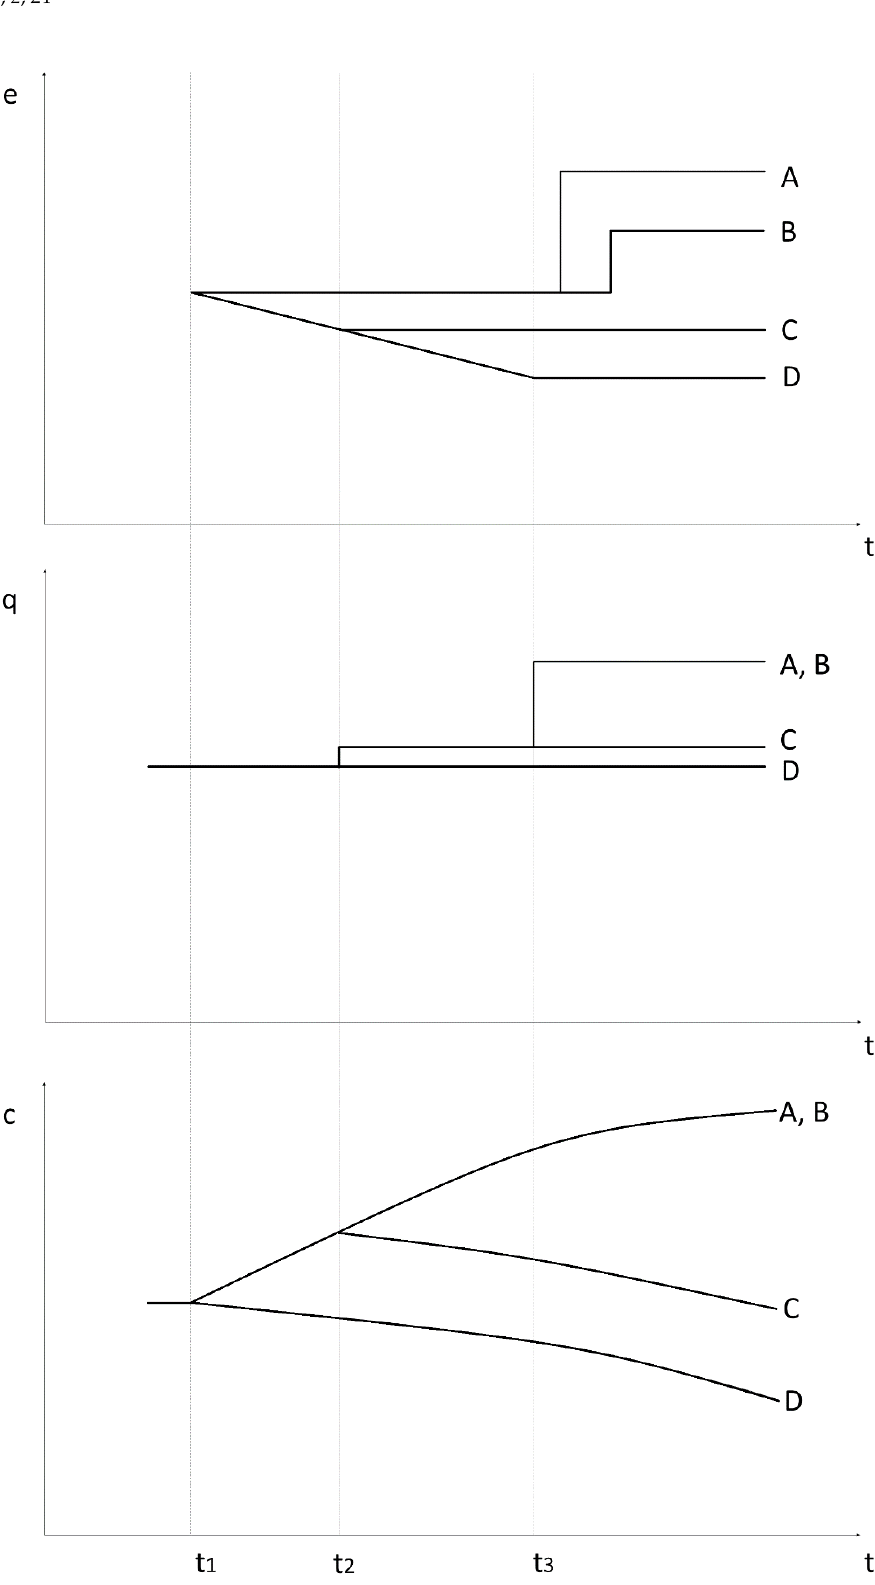
Figure 3. Education and training paths over time in the dimensions earnings ( e ), formal qualification ( q ), and competence ( c ) over some timespan during the career of an individual, during which an education and training decision happens. Three instances during some individual’s career, indicated as t 1 < t 2 < t 3 . Four exemplary individual education and training paths are marked as A, B, C, and D.